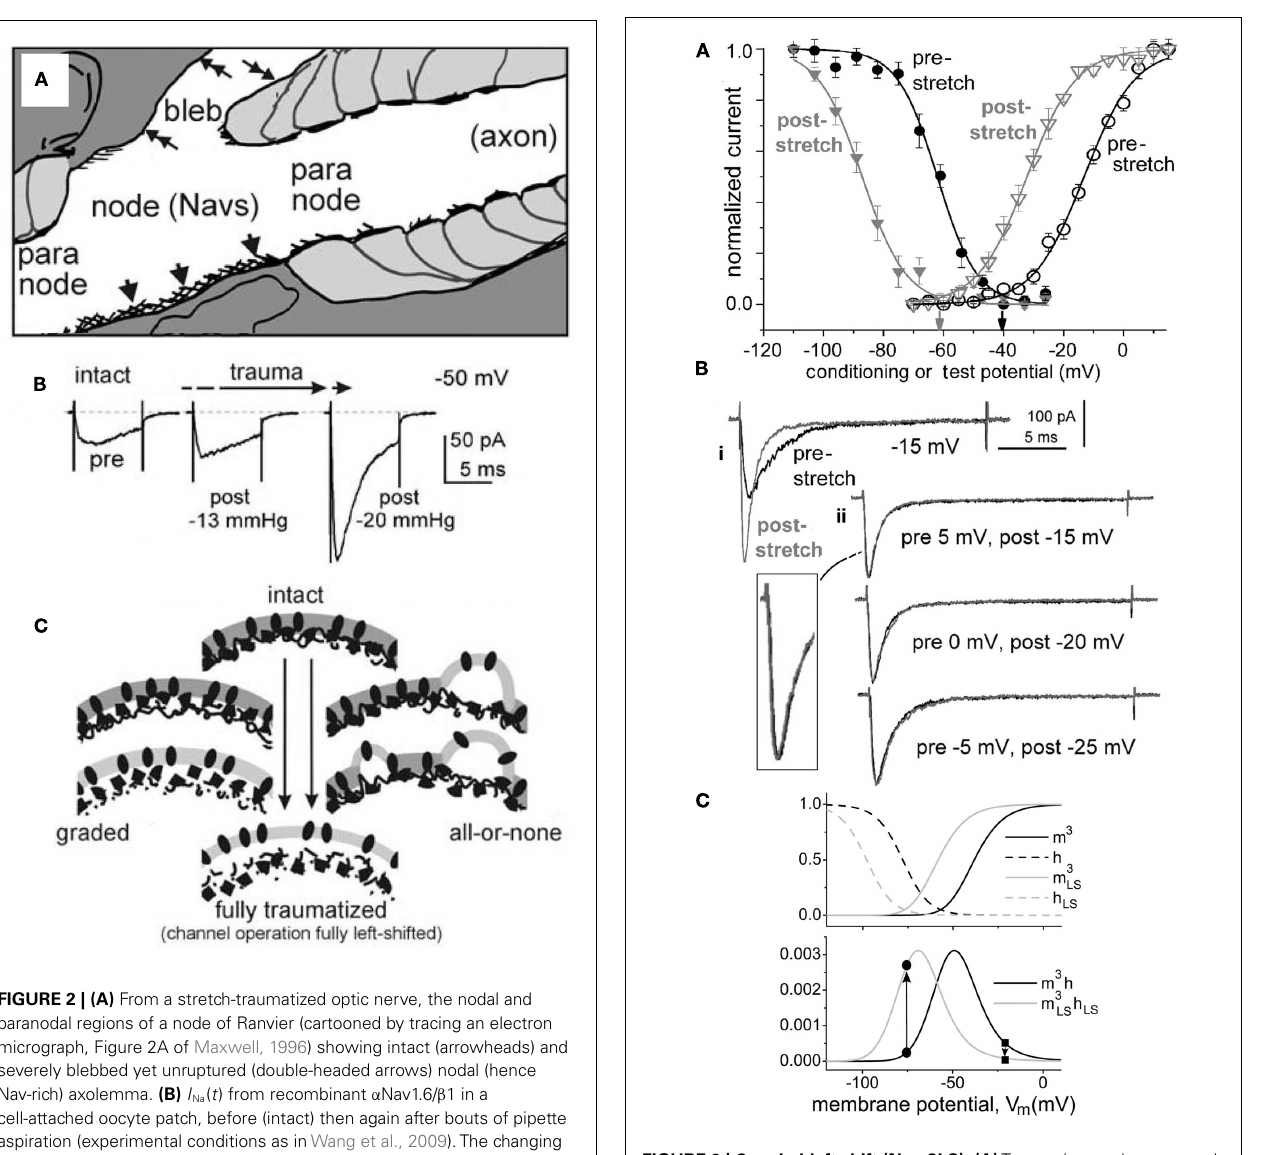
FIGURE 3 | Coupled-left shift (Nav-CLS). (A) Traumatic membrane stretch causes irreversible hyperpolarizing shifts of activation and steady-state fast inactivation (availability) for recombinant Nav1.6 (aspirated cell-attached oocyte patches; likewise in B ). (B) CLS as seen from I Na traces: i, I Na ( t ) during a step to − 15mV before and after stretch-induced membrane damage – the change is irreversible. ii Nav channels in this patch (same as i ) underwent a membrane-injury-induced CLS found to be of magnitude 20mV, as evidenced by the fact that amplitude-normalized pre/post I Na ( t ) traces measured at V m steps 20mV apart, as listed, have indistinguishable time courses (expanded section: pre 5mV, post − 15mV traces). CLS like this is observed whether left shifts are small or large (see Figure 3 ofWang et al., 2009).This justifies co-left-shifting of HH Boltzmanns, m 3 ∞ ( V ) and h ∞ ( V ) ( = availability), along the voltage axis ( Figure 1 legend) to model axonal Nav channels in trauma-injured membrane (Boucher et al., 2012). (C) Activation [ m 3 ( V )] and inactivation [ h ( V )] variables at t =∞ for regular HH-Nav channels and after each function is left-shifted 20mV (mimicking intact versus “strongly traumatized”).The product (lower panel) of overlapping activation and availability Boltzmann’s, m 3 h ( V ) = steady-state open probability or non-dimensional g window . Arrows: a 20-mV left-shift ( m 3 h LS ) increases g window near typical V rest while decreasing it nearer LS